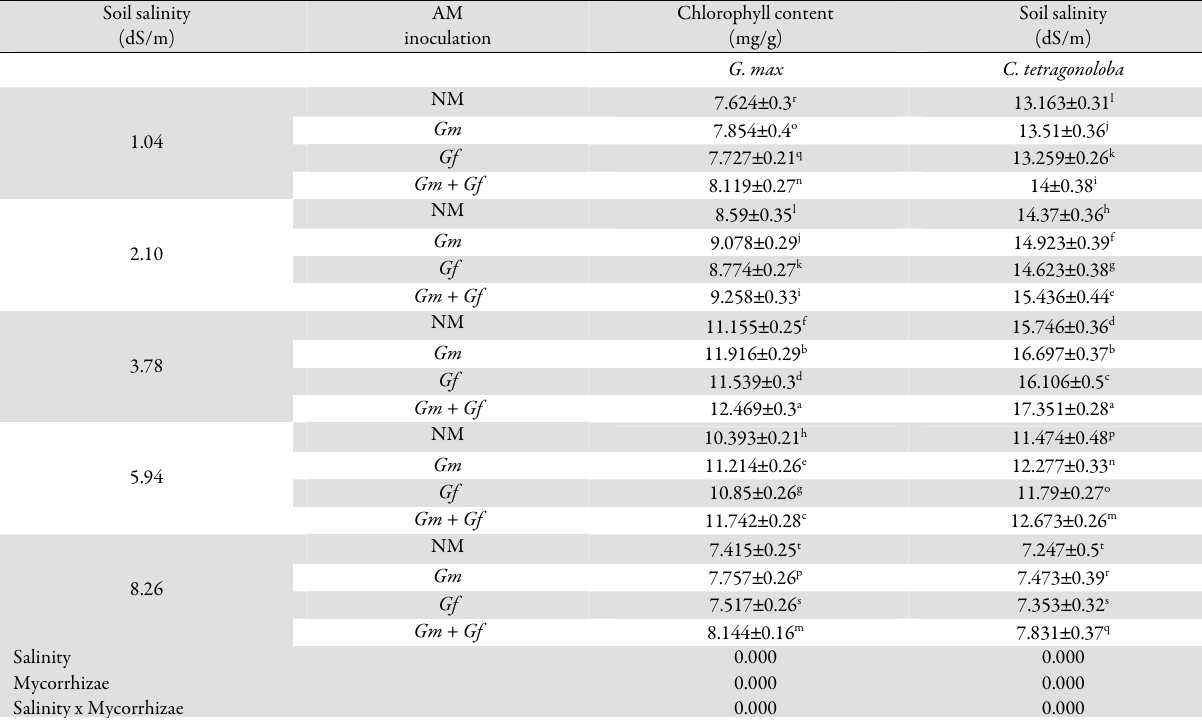
Tab. 5. Total reducing sugar content (mg/g) of mycorrhizal and non-mycorrhizal G. max and C. tetragonoloba grown under control (1.04 dS/m) and at increasing soil salinity levels (2.10 to 8.26 dS/m)